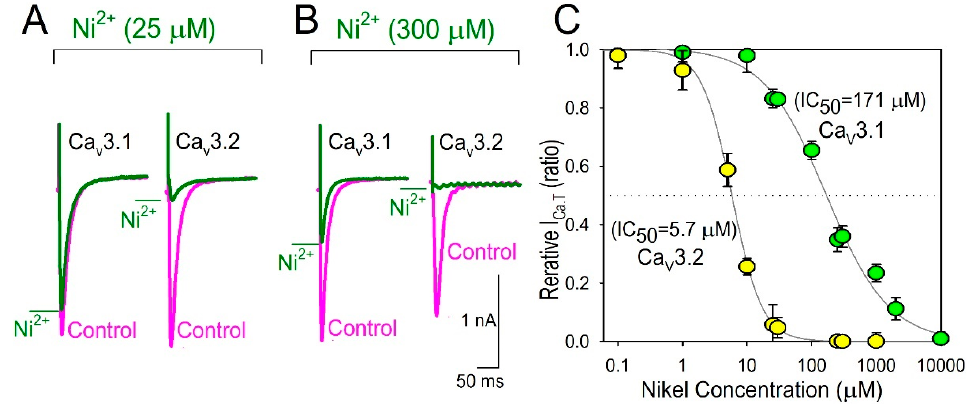
Figure 1. Effect of Ni 2+ on the Cav3.1 channel and the Cav3.2 channel. Representative Cav3.1- and Cav3.2-T-type Ca 2+ channel current traces obtained from recombinant HEK-Cav3.1 and Cav3.2 cells, respectively. Traces were recorded at the test potential of 0 mV from the holding potentials of -120 mV. Actions of 25 μ M Ni 2+ ( A ) and 300 μ M Ni 2+ ( B ) on I Ca.T were assessed 5 min after the bath appli- cation (green lines) in comparison with control (magenta lines) in the same patch. ( C ) Dose–response curve for the block of I Ca.T by Ni 2+ . Data represent the average ( ± S.D.) responses from 8 to 12 cells. The smooth curves represent the fit of the Hill equation to the data with IC 50 of 5.7 μ M (Cav3.2, in yellow circles) and 171 μ M (Cav3.1, in green circles).